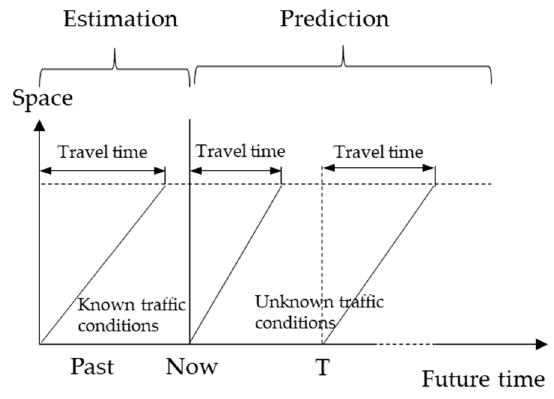
Figure 2. Estimation and prediction notations on bus travel time [28].